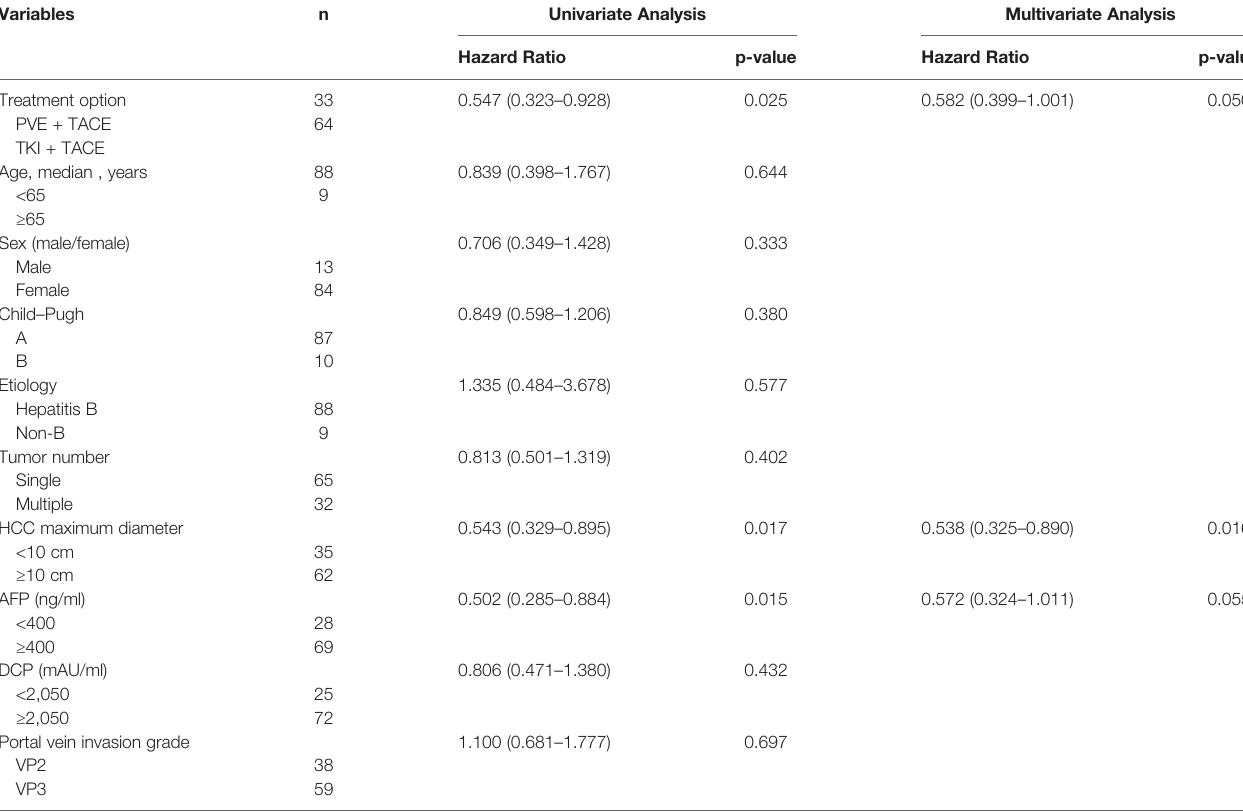
TABLE 3 | Univariate and multivariate analysis of predictors associated with overall survival in total cohort.